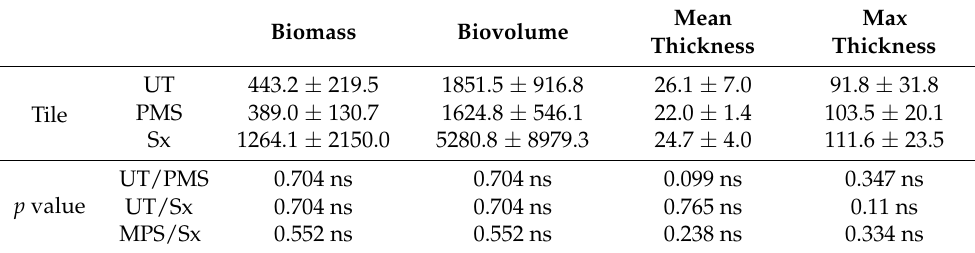
Table 2. Macroscopy analysis of biomass ( µ m 3 · µ m − 2 ), biovolume ( µ m 3 ), mean and mean thickness ( µ m) with statistical analysis (Wilcox test), ns not